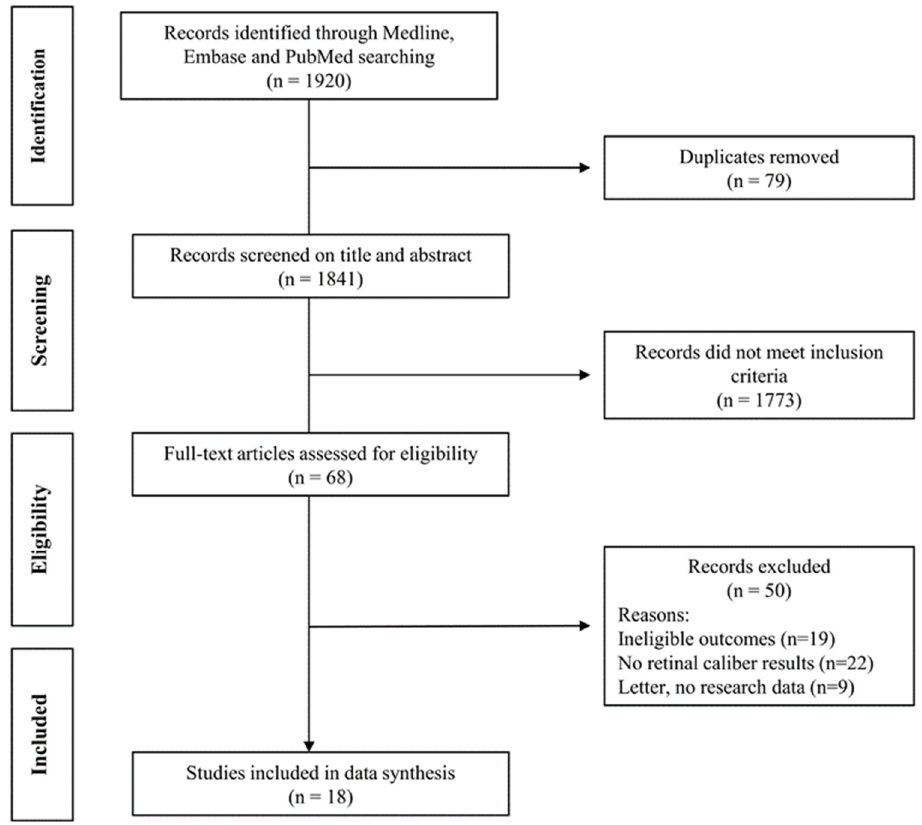
Figure 1. Flow diagram detailing numbers of studies searched, screened and included in the review. Table 1. Study characteristics of those reporting RVC and lifestyles for children and adolescents.